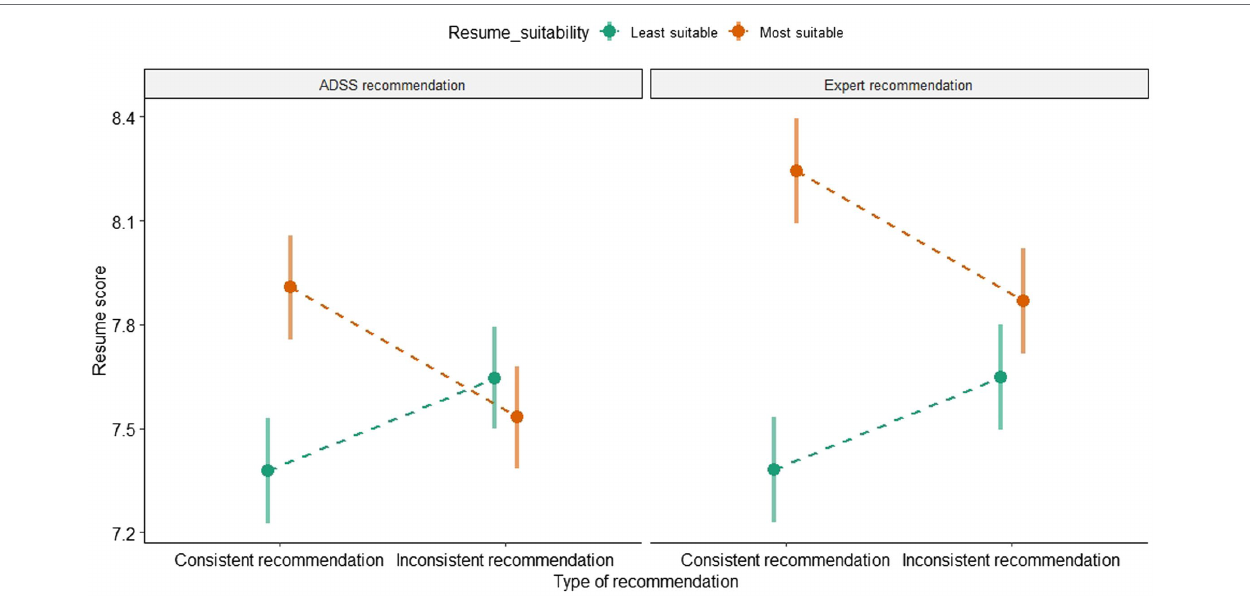
FIGURE 3 | Influence of recommendations type and consistence on resume score.